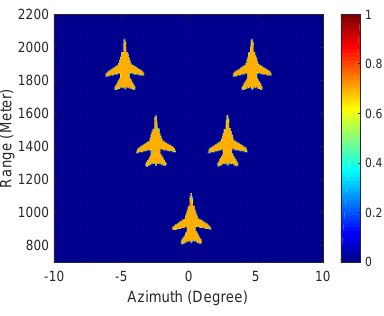
Figure 4. An original scene of the targets